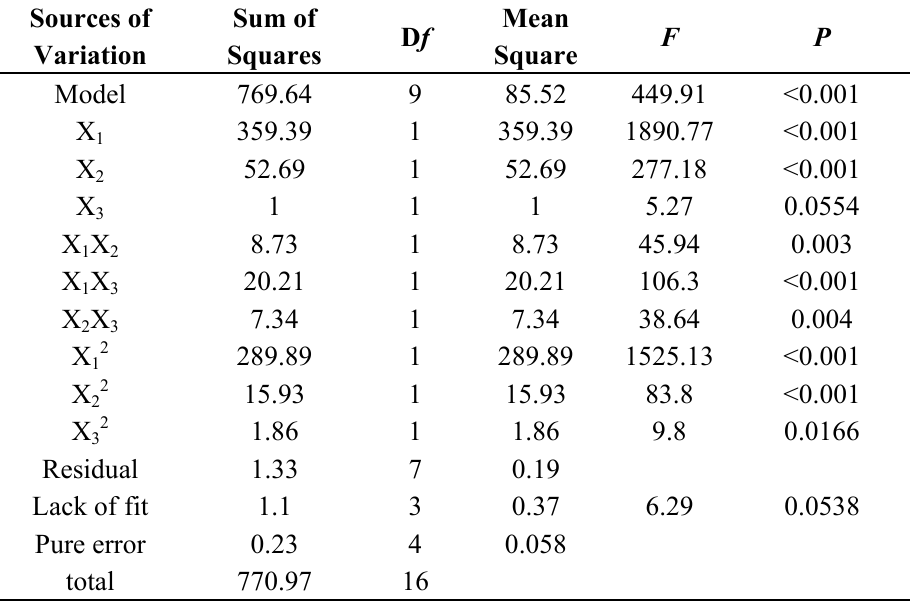
Table 3. Analysis of variance (ANOVA) of the response Y (FFA%) of the Box-Behnken design.